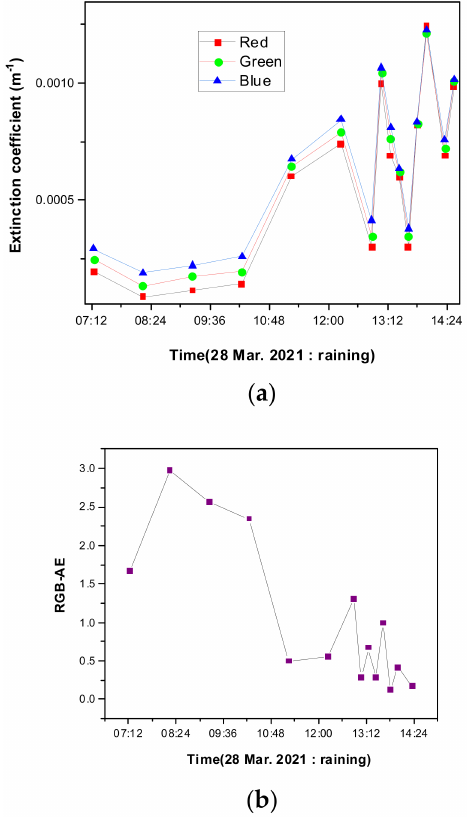
Figure 9. Extinction coefficients and AE characteristics on a rainy day (28 March 2021): ( a ) extinction coefficients and ( b )